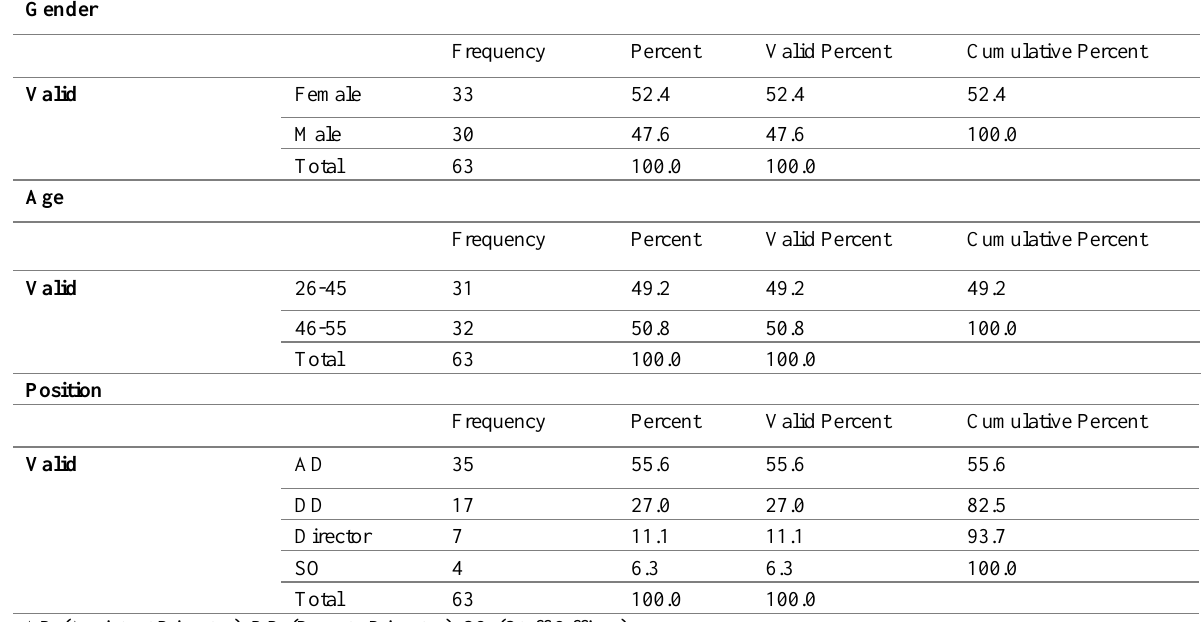
Table 3: Demographic Data of Respondents